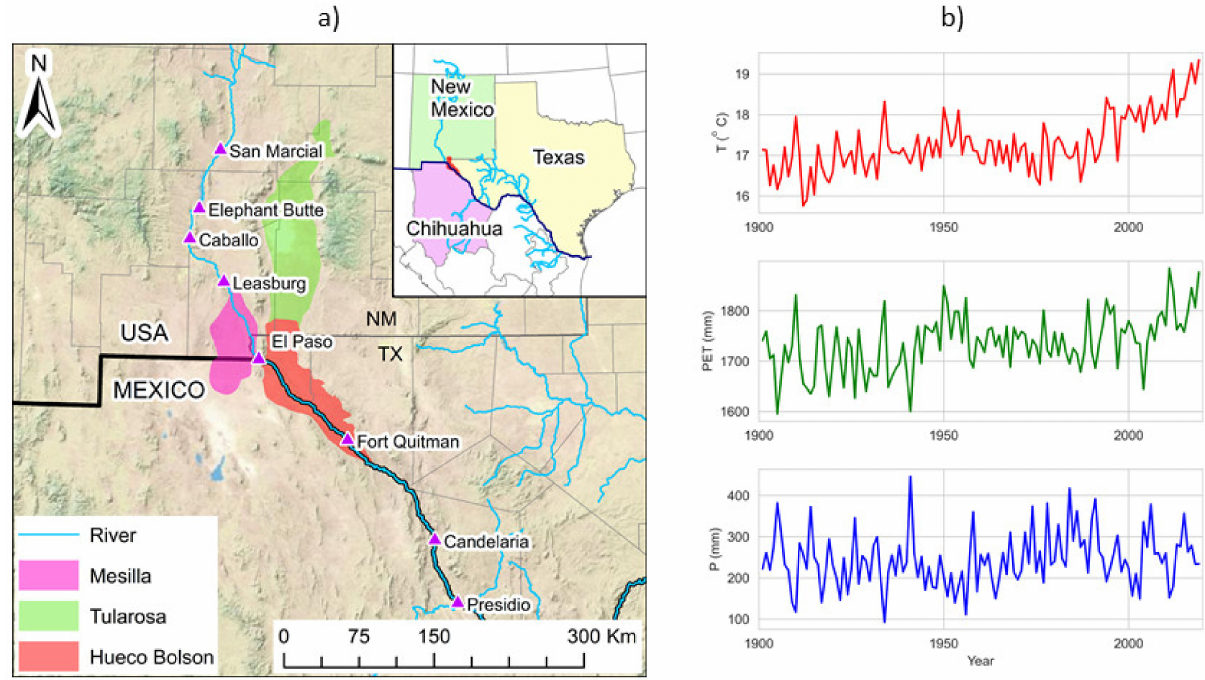
Figure 1. ( a ) Map showing Hueco Bolson and the adjacent Mesilla and Tularosa aquifers overlaid over administrative borders and the river channel. Triangles are streamflow gauging stations. Elephant Butte and Caballo are two reservoirs controlling the release of streamflow. Inset shows the Hueco Bolson aquifer (red), located in two states of the USA states (Texas and New Mexico) and the state of Chihuahua, Mexico; and ( b ) the inter-annual variation in average temperature (T), potential evapotranspiration (PET), and precipitation (P) from 1901 to 2019 across the Hueco Bolson